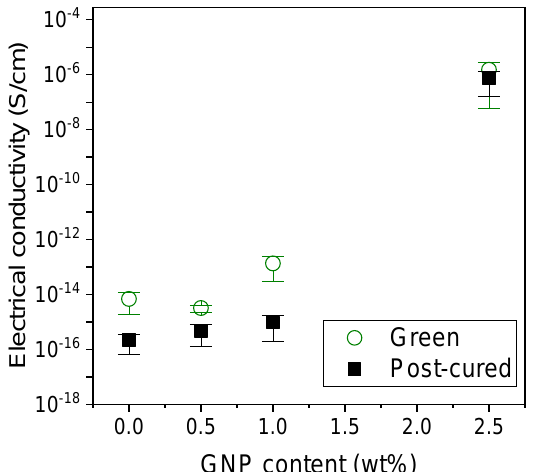
Figure 8. Electrical conductivity for the green and post-cured nanocomposites containing 0–2.5 wt %